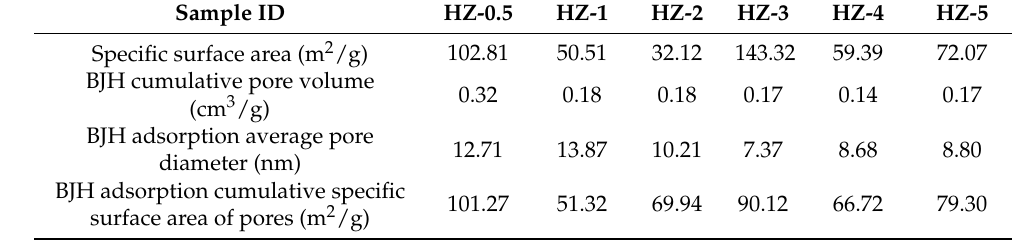
Table 3. BET/BJH results of the synthesized composite samples.